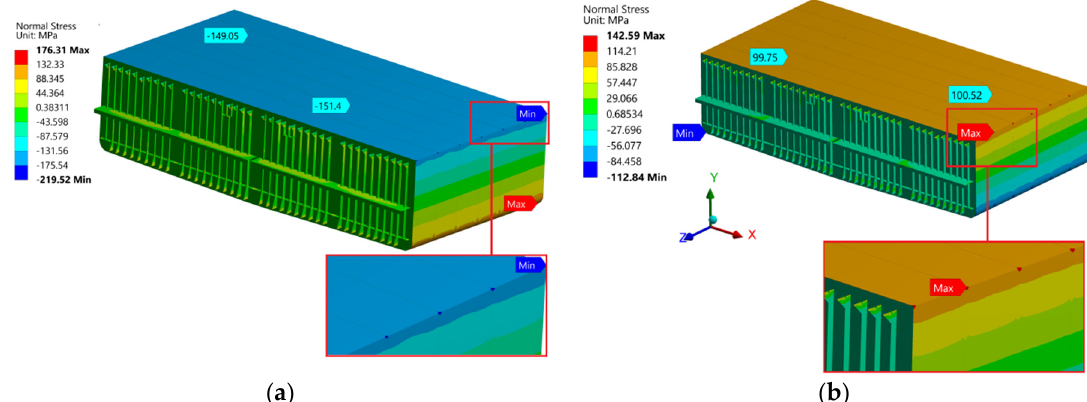
Figure 11. Normal stress distribution in z direction of the central tank generated by: ( a ) Sagging bending moment of 906.88 × 10 6 Nm and ( b ) Hogging bending moment of 599.10 × 10 6 Nm.